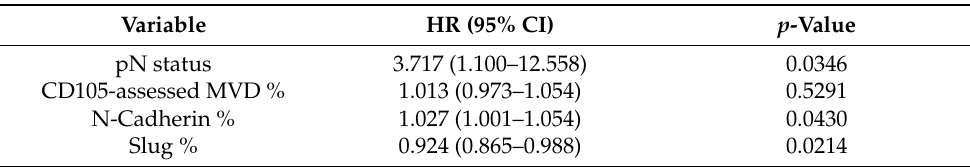
Table 2. Multivariate Cox regression analysis results on the variables which showed a p -value of <0.10 in the univariate